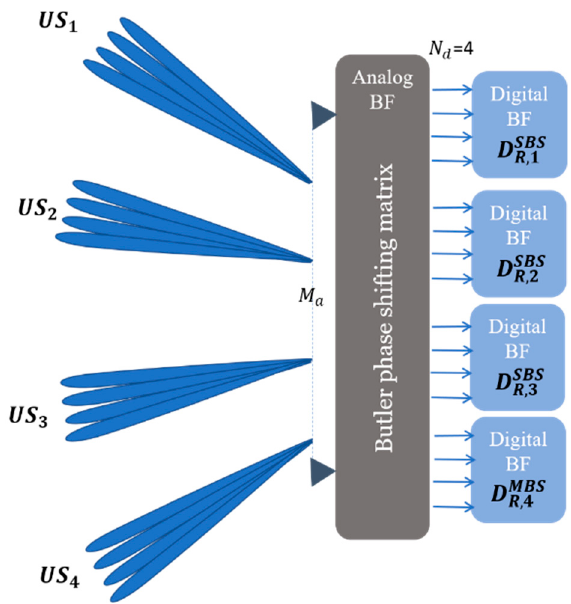
Figure 4. Hybrid beamforming based on Butler matrix for the access link.